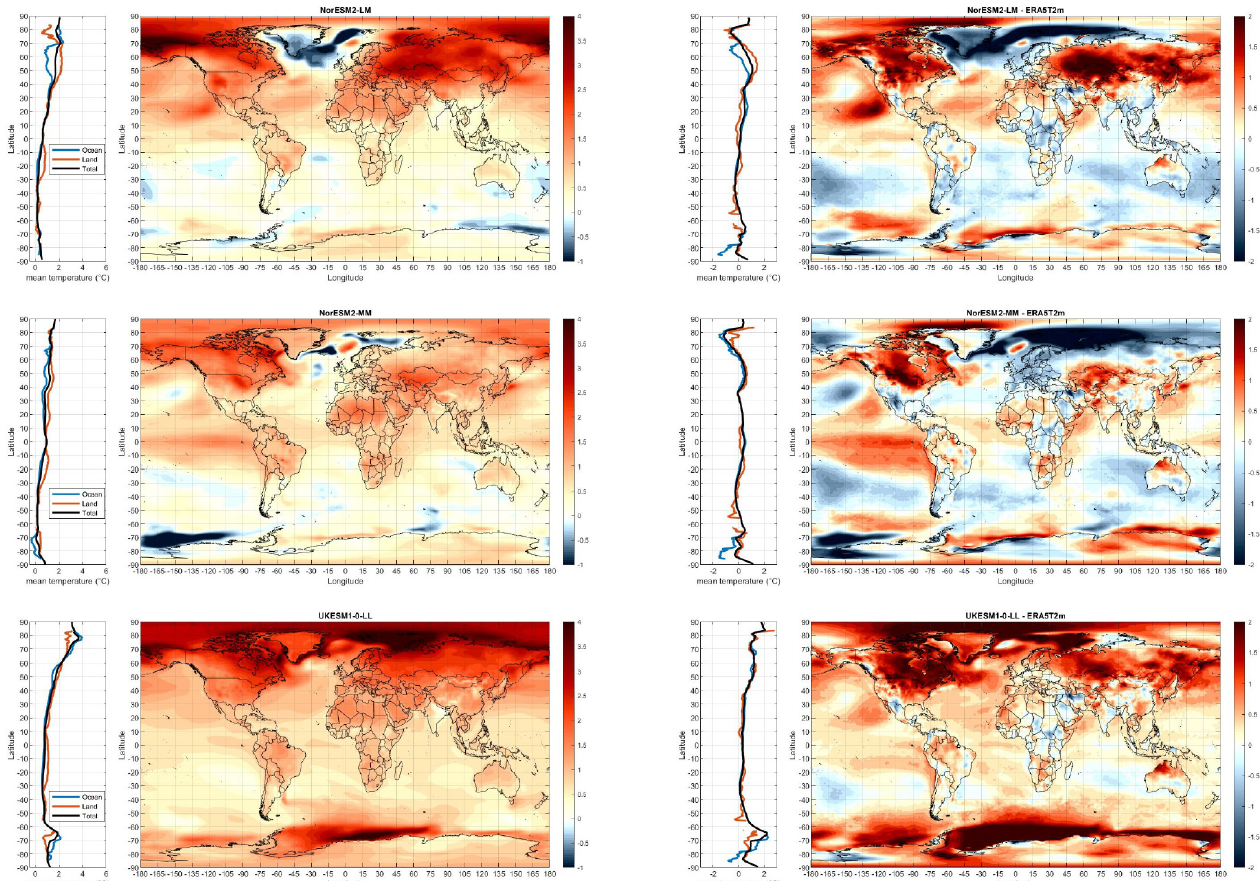
Figure A8. Warming patterns from 1980–1990 to 2011–2021 for the indicated CMIP6-tas GCM ( left ) and its comparison against the ERA5-T2m record ( right